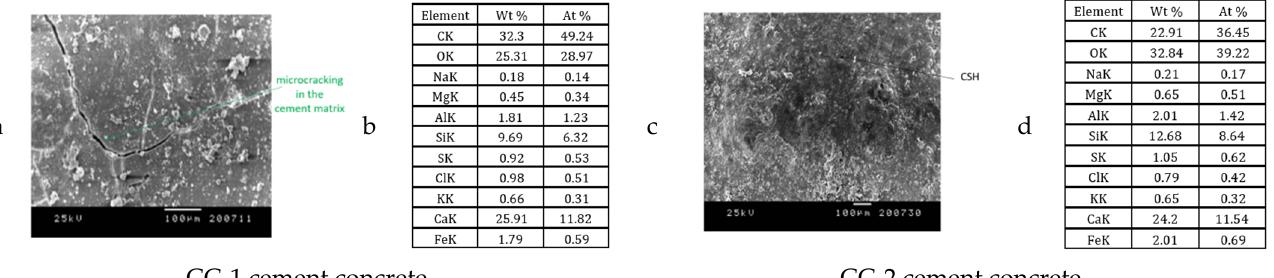
Figure 22. Concrete surface subjected to thermal cycles according to scheme A for CC-1 and CC-2 concrete: ( a , c ) sample surface, ( b , d ) chemical microanalysis.